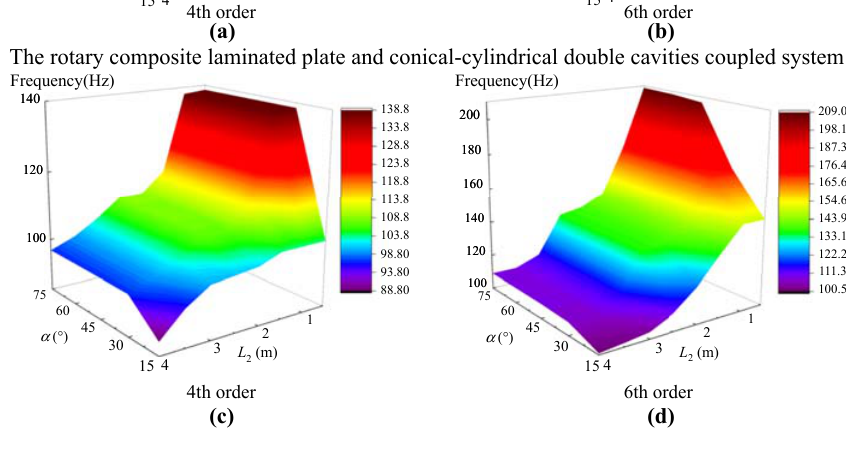
Figure 6. The surface diagram of the natural frequency of the coupled systems with differentheight L 2 and cone-apex angle